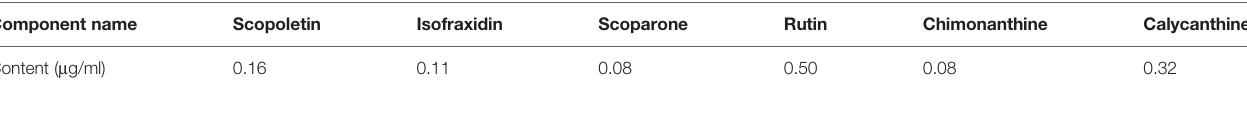
TABLE 2 | Quanti fi cation of the components of